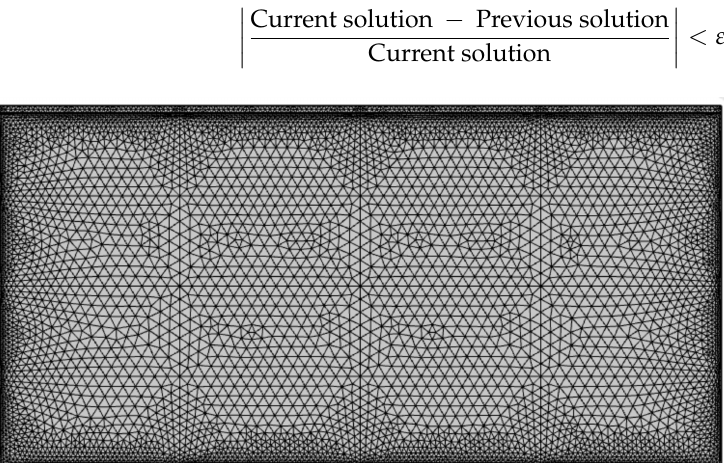
Figure 2. Meshing of the nanofluid and the elastic absorber